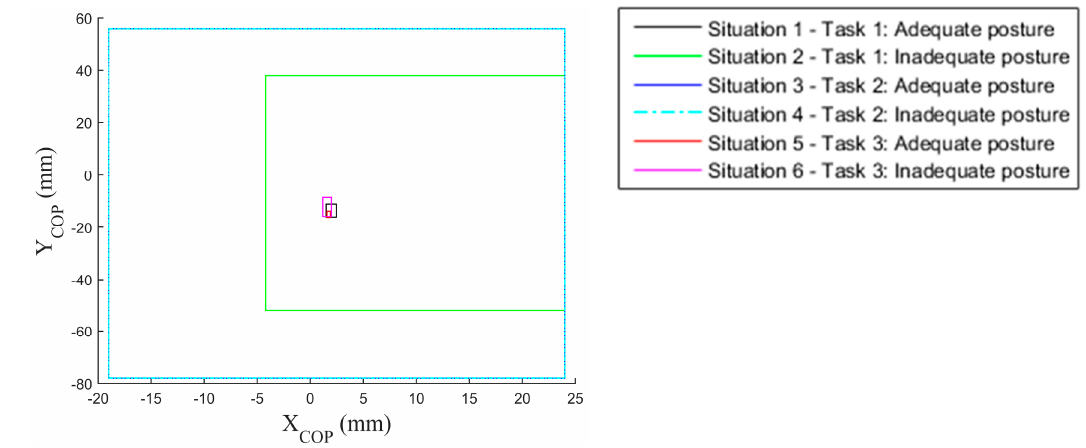
Figure 12. Areas containing the COP displacements measured in different situations.